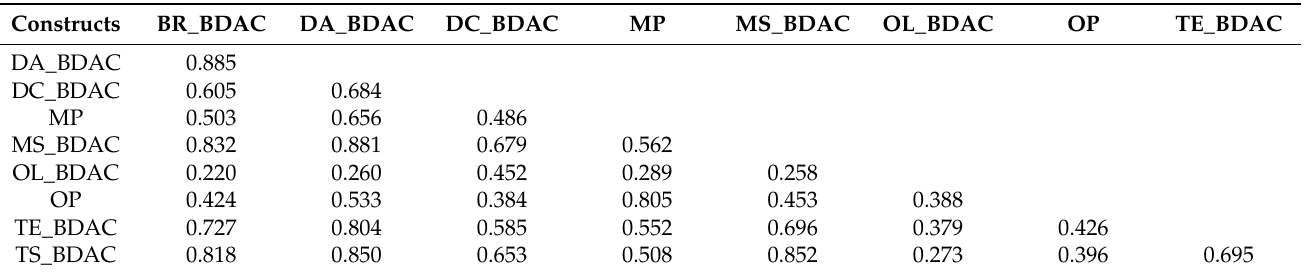
Table 2. Discriminant validity